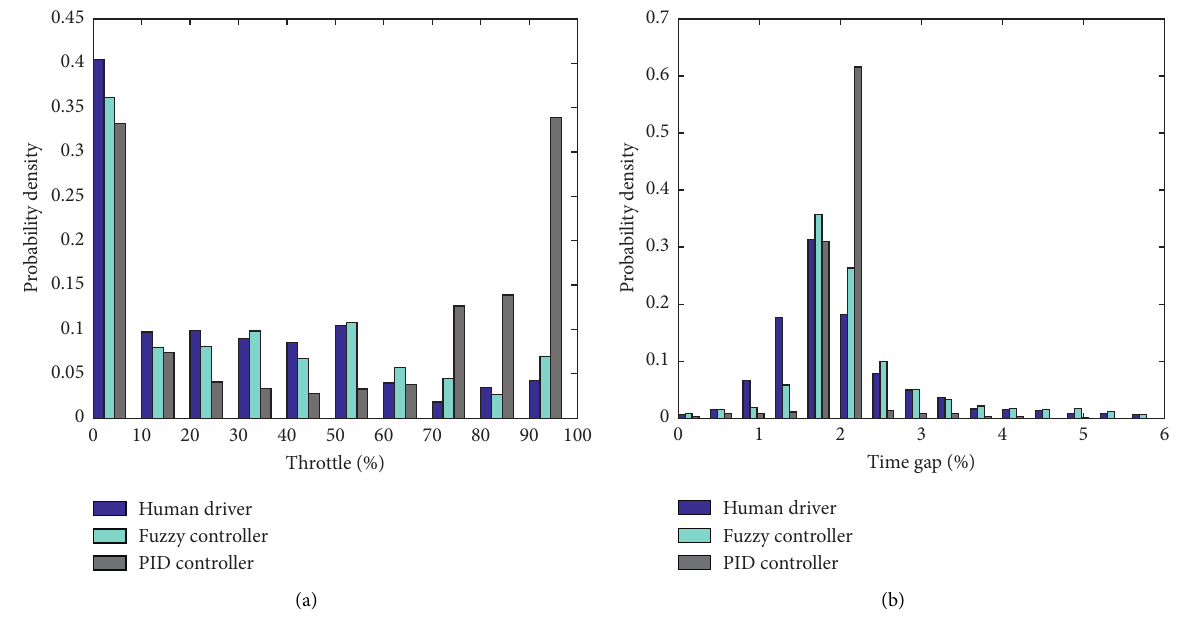
Figure 8: Driver model examination. (a) Throttle pedal. (b) Time